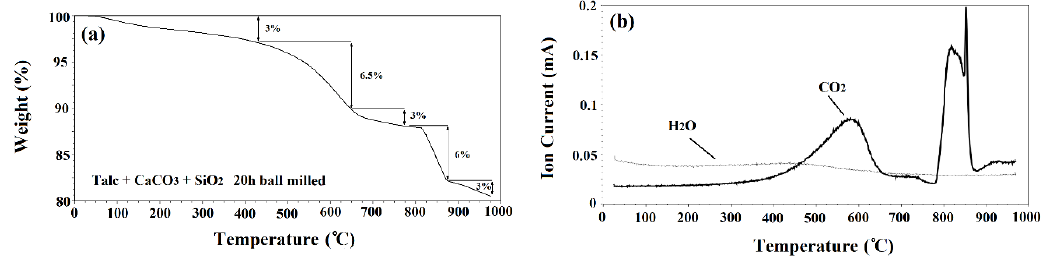
Figure 1. ( a ) TG and ( b ) mass spectrometry of powders after 20 h ball milling time.